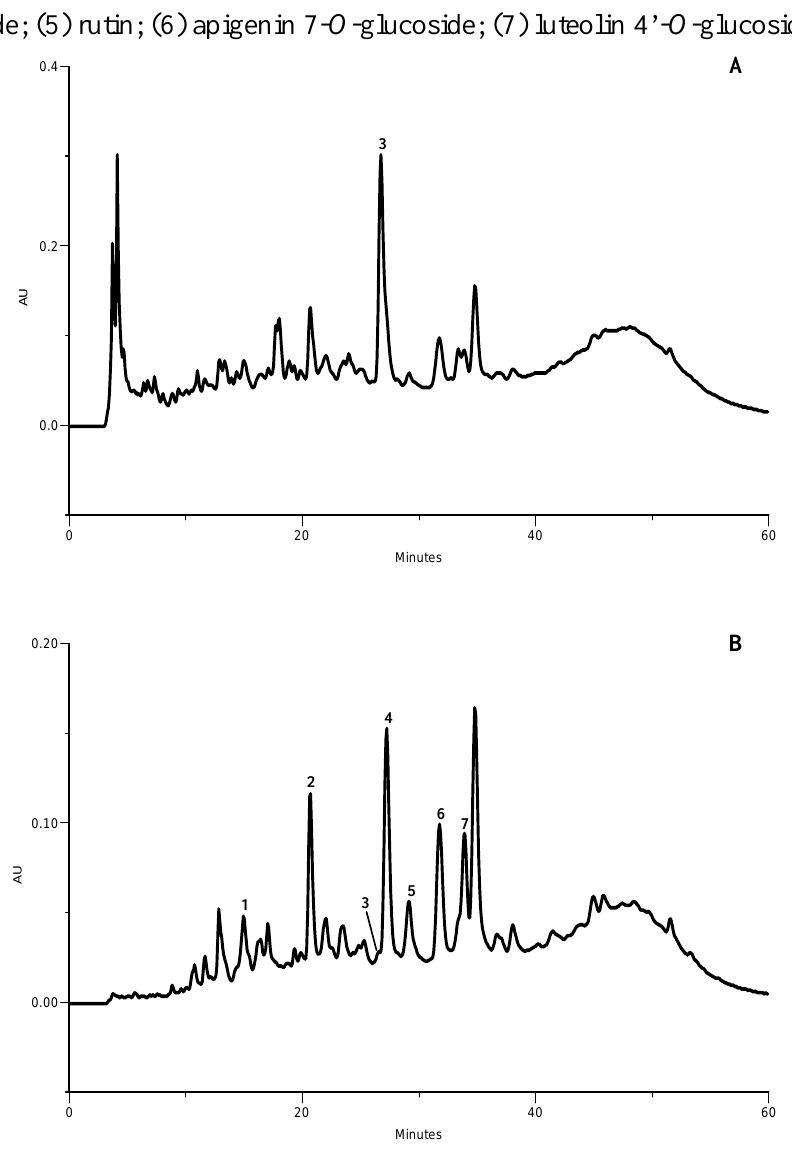
Figure 1. HPLC phenolic profile of olive leaf lyophilized extract. Detection at (A) 280 and (B) 350 nm. (1) caffeic acid; (2) verbascoside; (3) oleuropein; (4) luteolin 7- O - glucoside; (5) rutin; (6) apigenin 7- O -glucoside; (7) luteolin 4’- O -glucoside. testemunha cobrançosa 1